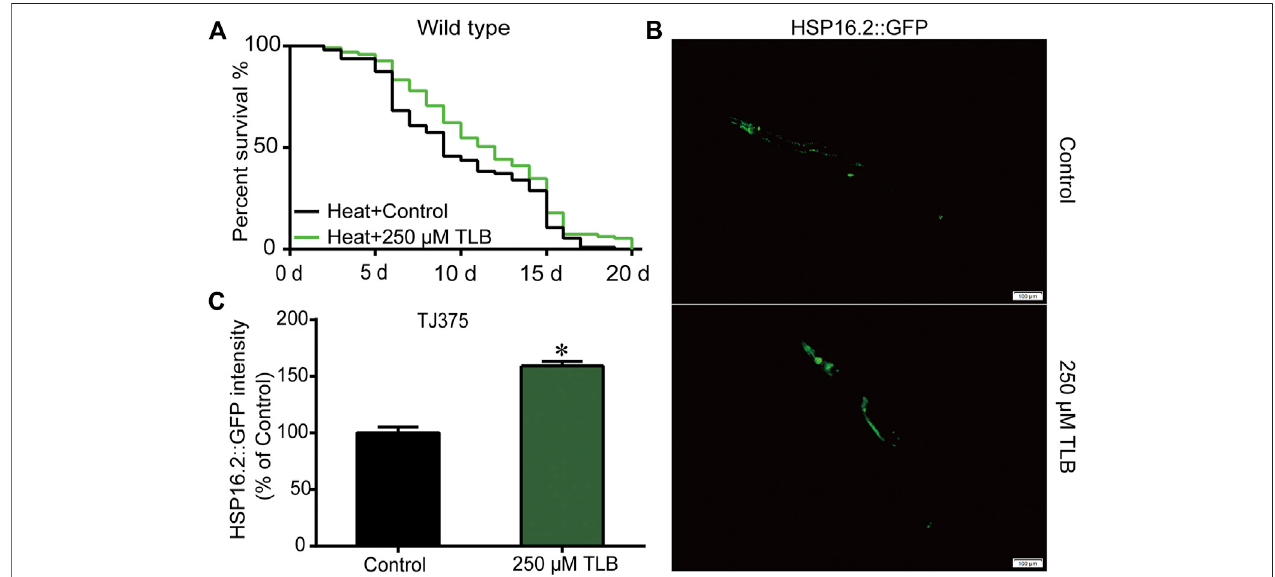
FIGURE 3 | TLB reinforced the heat stress tolerance of C. elegans . Wild type C. elegans were treated with or without TLB under 35 ° C condition. (A) The Kaplan- Meier survival curves under 35 ° C condition ( n (cid:2) 94 – 95). (B) The HSP16.2 transgenic C. elegans were treated by heat stress at 35 ° C for 72 h, and the fl uorescence of C. elegans were observed under a fl uorescence microscopy. (C) The mean pixel fl uorescence intensity of protein HSP16.2 were quanti fi ed using the Image Pro Plus 6.0 software ( n (cid:2) 20). Magni fi cation × 100; scale bar, 100 μ m. Data were presented as mean ± SEM. * p < 0.05 vs. non-TLB treated controls.